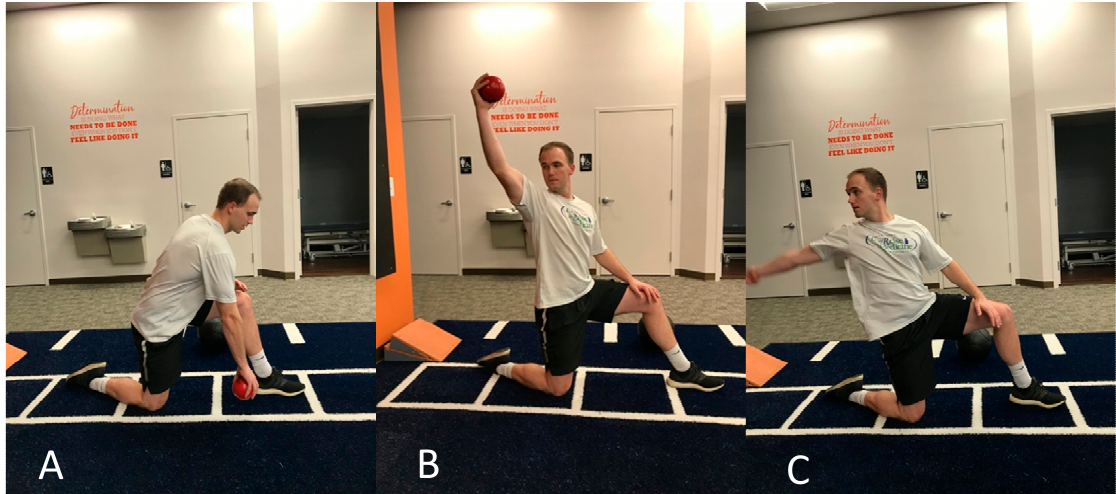
Figure 3. Reverse plyo-ball throw against wall working on rapid eccentric loading of biceps brachii. ( A ) Starting phase, ( B ) rapid shoulder flexion acceleration with supinated wrist, ( C ) deceleration phase after ball release.